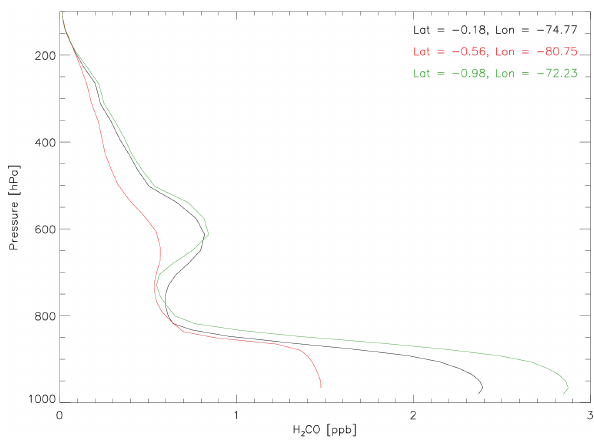
Figure 4. Three a priori H 2 CO profiles used in the air mass factor calculations for Orbit